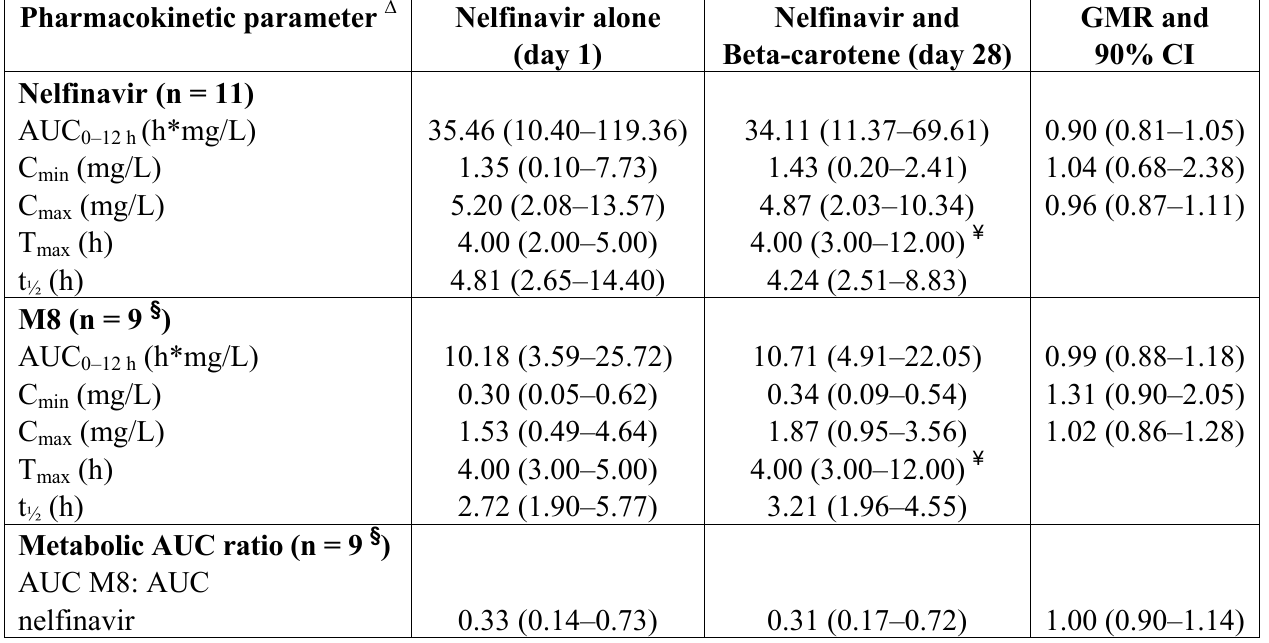
Table 2. Steady-state plasma pharmacokinetic parameters of nelfinavir and its M8 metabolite at baseline and after 28 days of β -carotene supplementation (25,000 IU twice